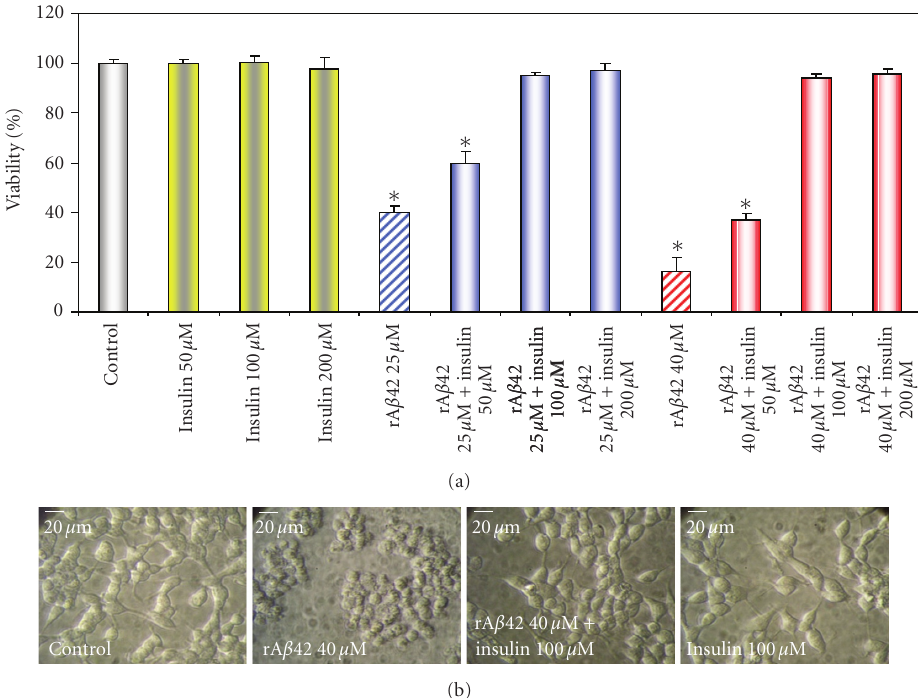
Figure 1: Dose dependence of protective e ff ect of insulin against rA β 42 oligomers induced cell death. (a) LAN5 neuroblastoma cells were untreated (control) or incubated with insulin 50 or 100 or 200 μ M of insulin alone or after incubation with 25 or 40 μ M of rA β 42. After incubation treated and untreated cells were submitted to viability MTS assay. Cell viability is significantly lower in rA β 42 25 μ M ∗ P < . 01, rA β 42 25 μ M + insulin 50 μ M ∗ P < . 01 versus control, whereas it is not significantly lower with rA β 42 25 μ M + insulin 100 μ M versus control. Cell viability is significantly lower in rA β 42 40 μ M ∗ P < . 003, rA β 42 40 μ M + insulin 50 μ M ∗ P < . 003, whereas it is not significantly lower with A β 40 μ M + insulin 100 μ M versus control. Percentage of viability is referred to control, the data are the mean ± SD of three separate experiments. (b) Representative morphological images of LAN5 untreated cells (control), treated with rA β 42 40 μ M, rA β 42 40 μ M,